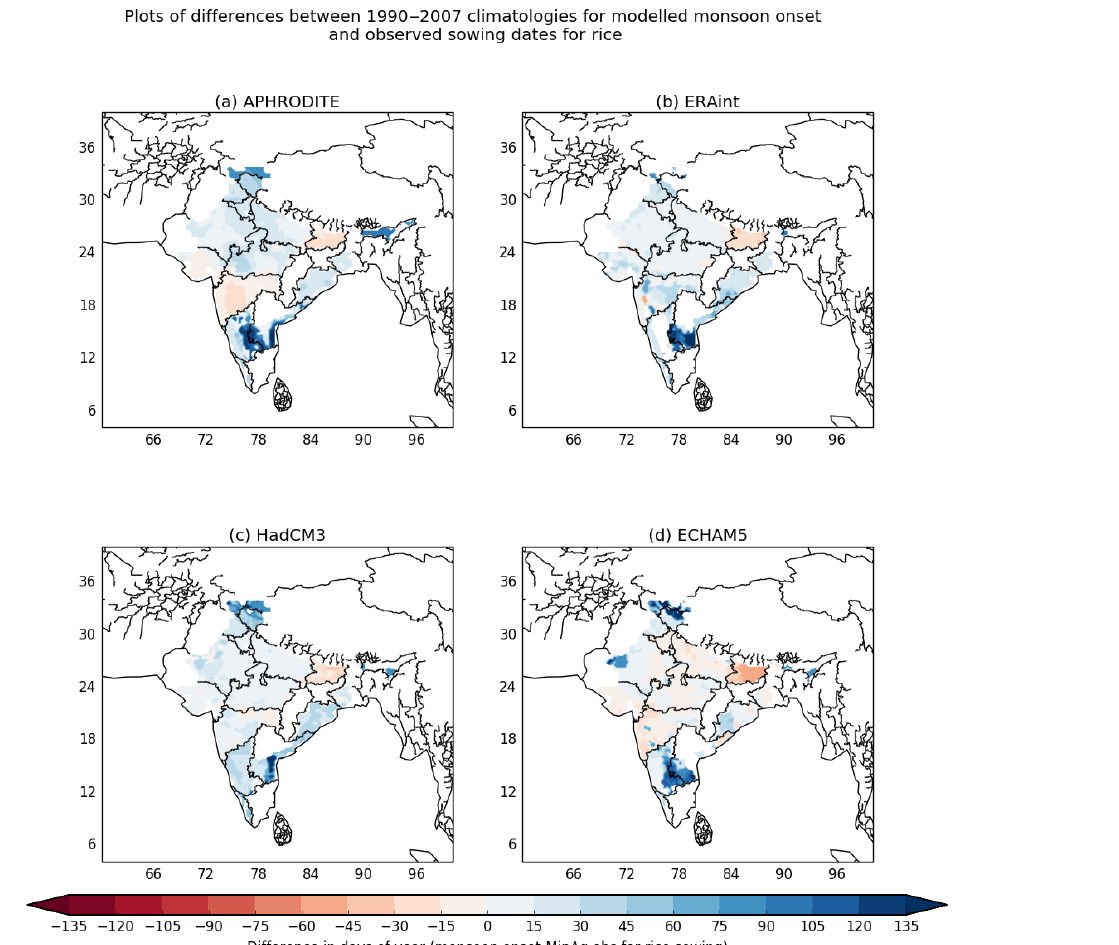
Figure 5. Plots of the difference between the midpoint of the monsoon onset in the model and the midpoint of the observed rice sowing period for